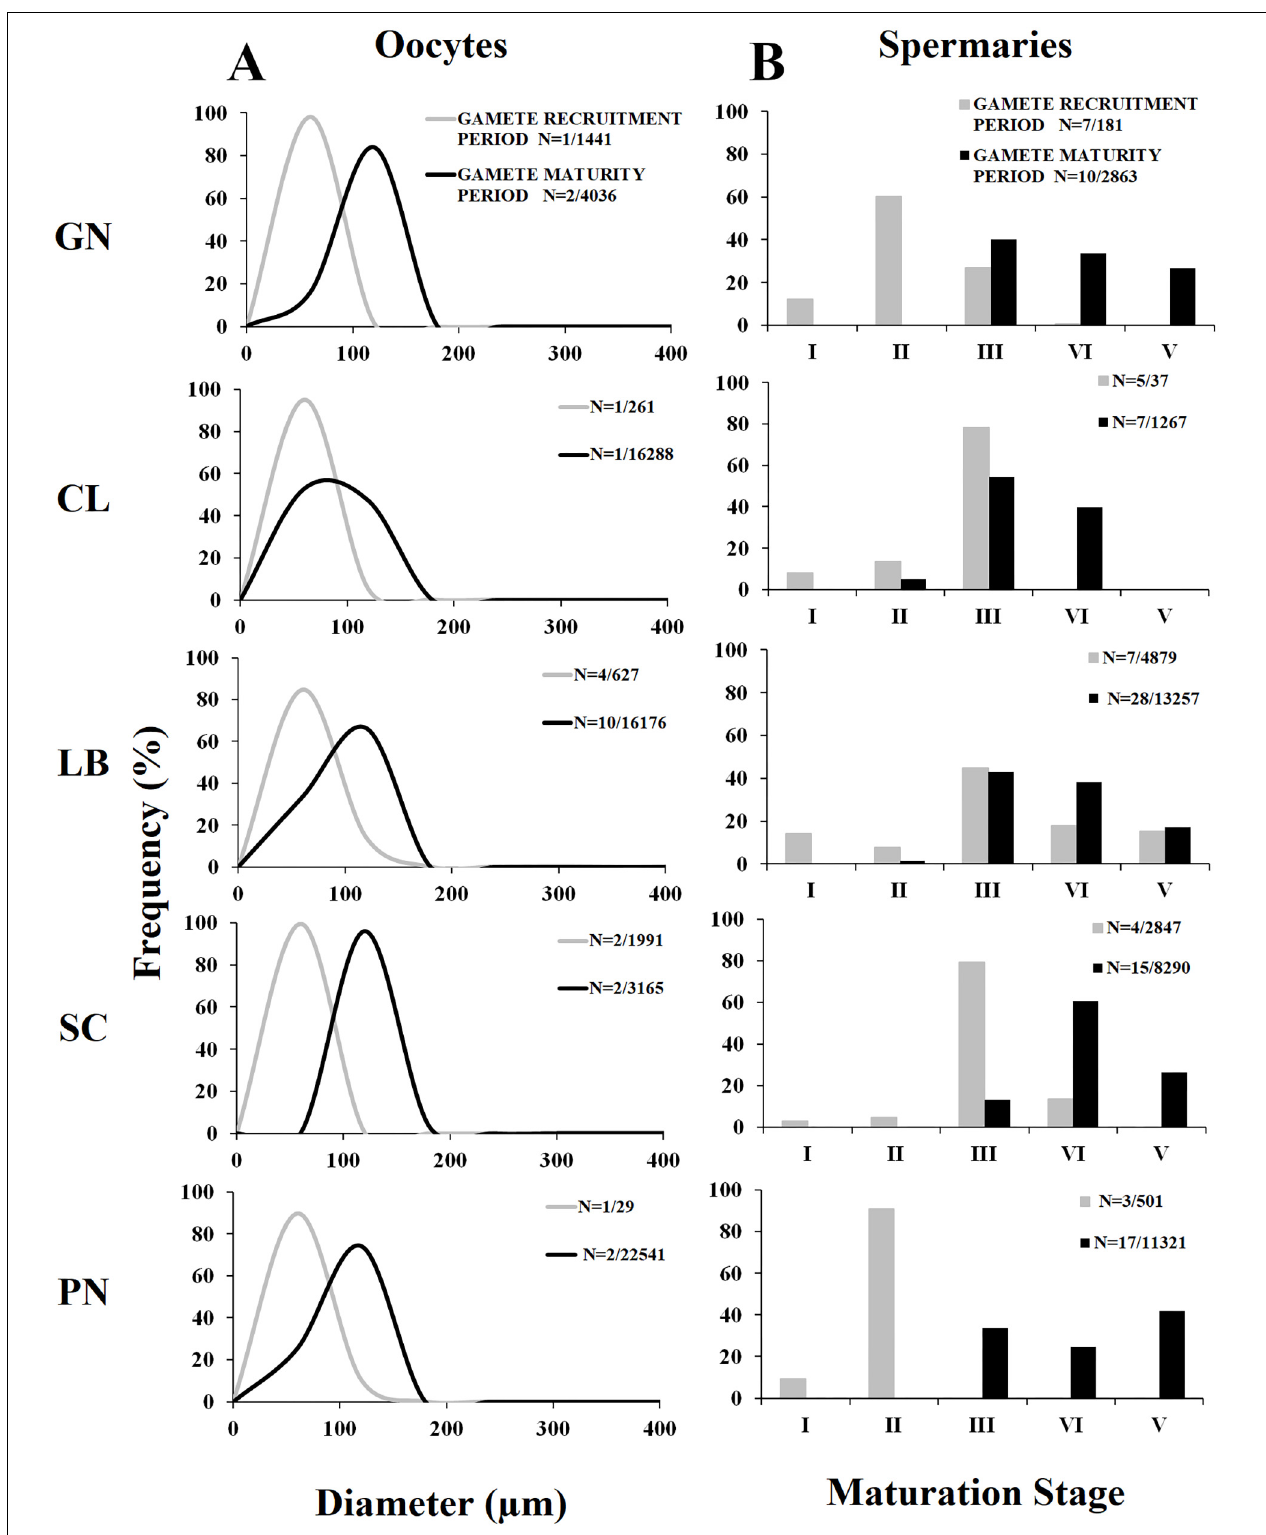
FIGURE 2 | Oocyte size and spermary maturation stage distributions for the two reproductive periods. (A) Distribution of oocyte size during gamete recruitment (gray line) and gamete maturity (black line) periods. N = number of polyps/oocytes. (B) Distribution of the five maturation stages of spermaries during gamete recruitment (gray histogram bars) and gamete maturity (black histogram bars) periods. N = number of polyps/spermaries.